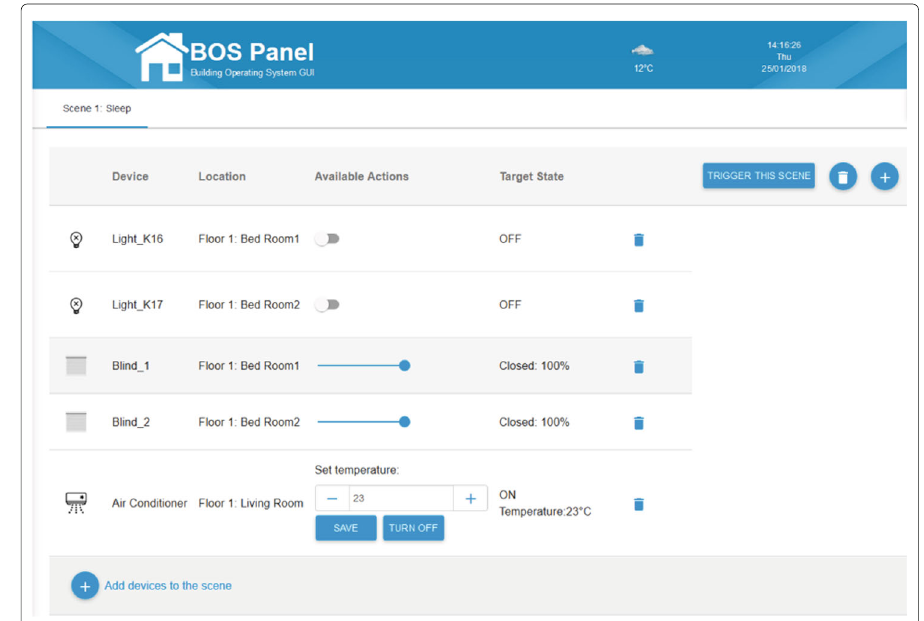
Fig. 19 BOS UI: an exemplary scene